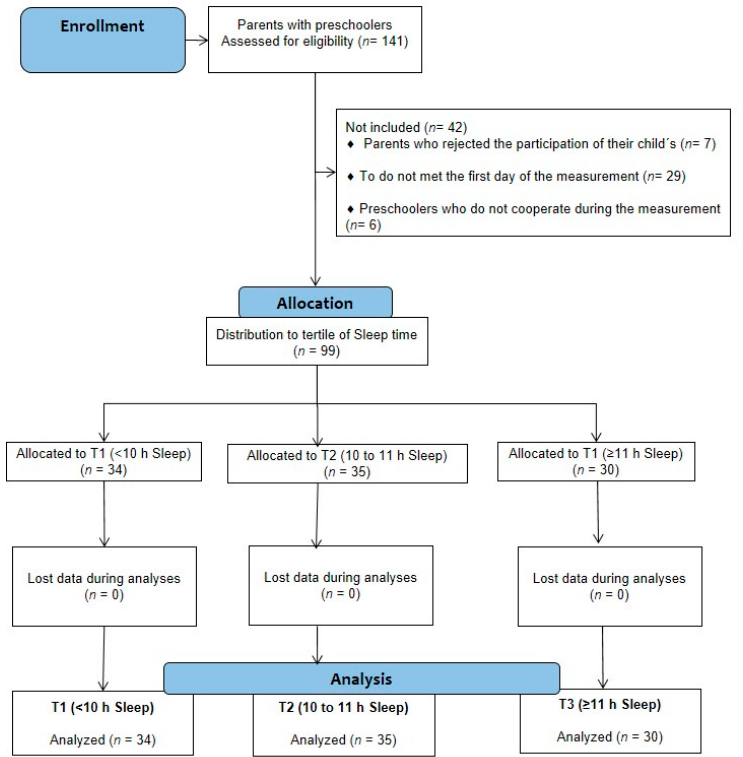
Figure 1. Study design. (T1: < 10 h of sleep duration; tertil 2, T2: 10 to 11 h of sleep duration; tertil 3, T3: ≥ 11 h of sleep duration)